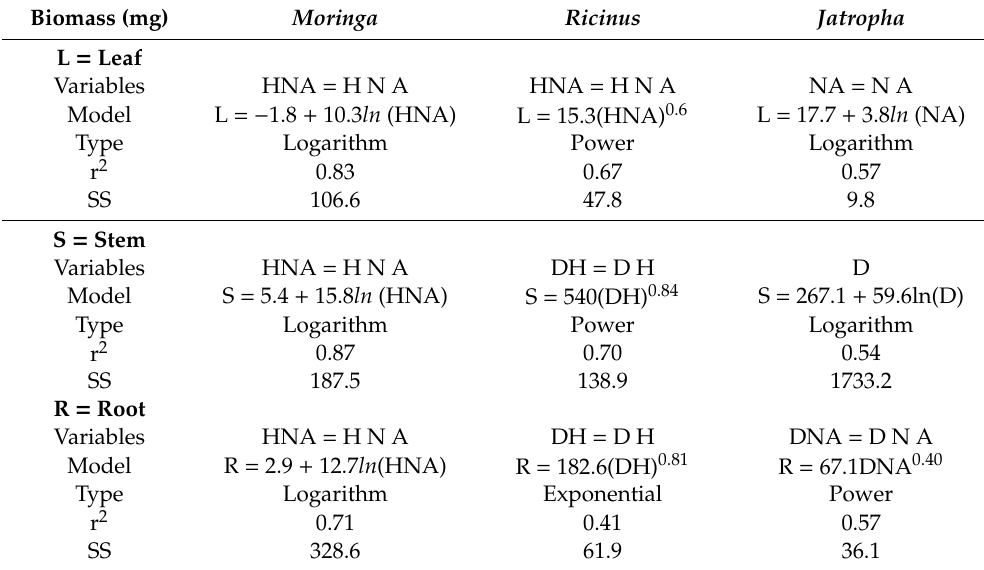
Table 10. Biomass estimation of Moringa , Ricinus , and Jatropha by their allometric relationships. Biomass (mg)